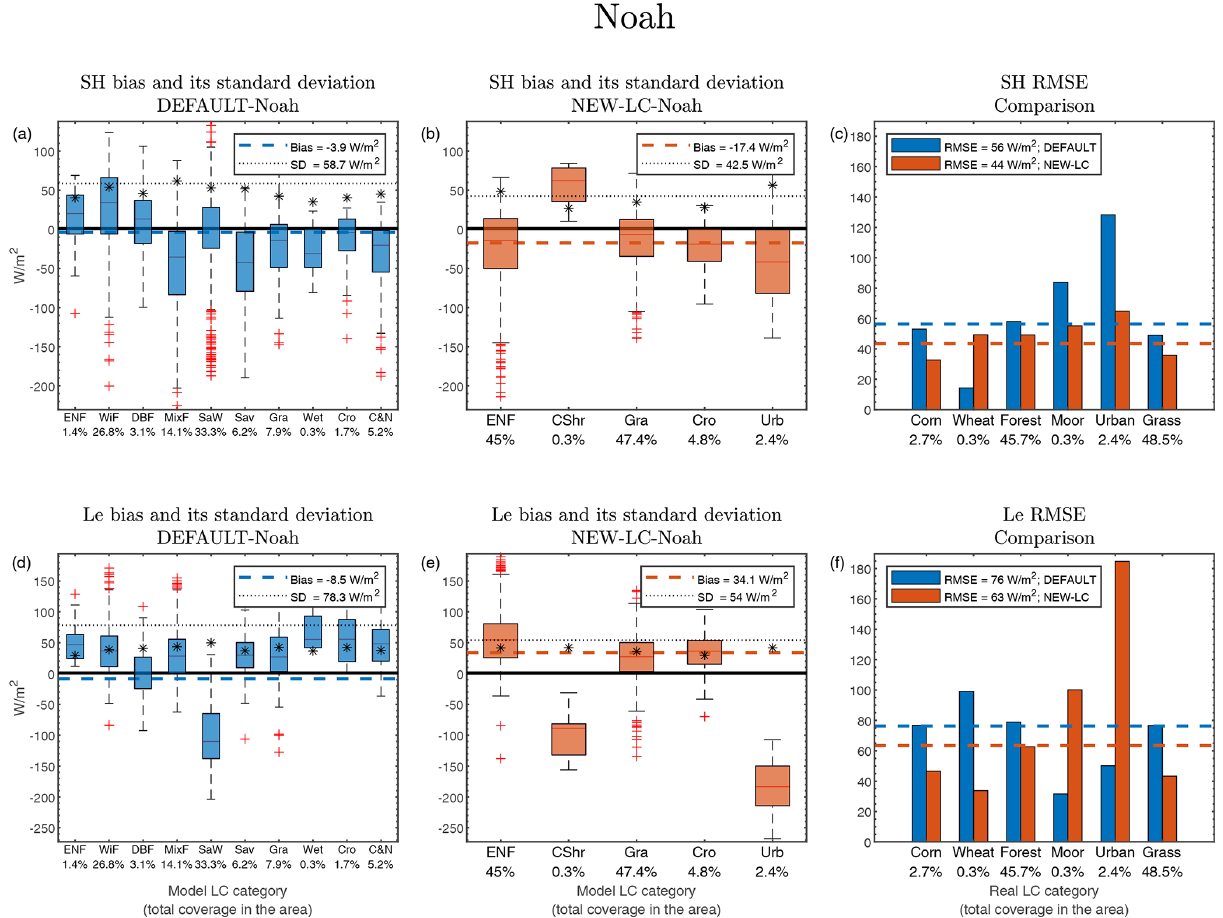
Figure 3. (a) Sensible heat flux (SH) bias box plots by model LC category ( x axis) for the default Noah simulation (DEFAULT-Noah). Values are calculated for all the pixels with the specific LC category as dominant in the entire analysed area from 09:00 to 15:00UTC (hourly values). The standard deviation (SD) is indicated with stars for each LC category. The horizontal coloured dashed line indicates the mean bias in the area analysed, and the black pointed line indicates the SD (these values are also indicated in the legend). The horizontal black solid line indicates the line of 0Wm − 2 bias. The box plots indicate the 50% of the distribution (from percentile 25 to percentile 75), the upper and lower whiskers the rest of the distribution, and the red crosses the outliers. Note that these figures include the variability due to the number of pixels with the same LC category as the dominant one (variable depending on their coverage) and also the variability due to the 7h analysed. (b) Same for the results obtained from the Noah simulation with the improved LC (NEW-LC-Noah). (c) SH root mean square error (RMSE) for DEFAULT-Noah and NEW-LC-Noah for each real LC in the area. The horizontal dashed lines indicate the mean RMSE for the whole analysed area. (d–f) Same as (a) – (c) but for the latent heat flux (Le). The percentages included with the x labels refer to those covered by each category with respect to the total evaluated